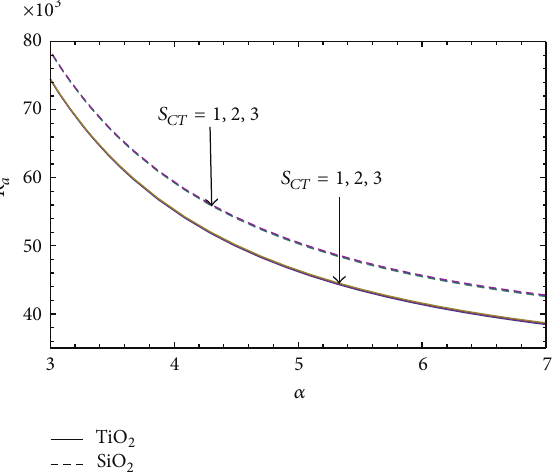
Figure 9: Effect of 𝑆 𝑇𝐶 on metallic nanoparticles.